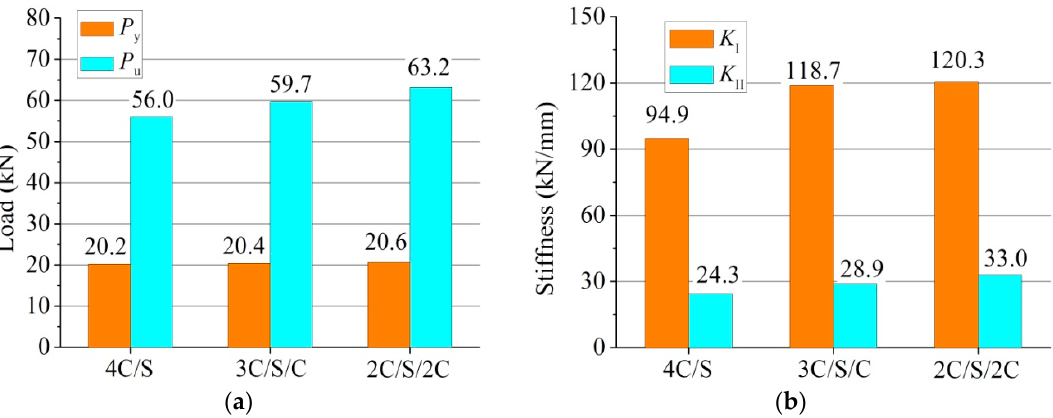
Figure 8. Effects of strengthening schemes: ( a ) yield and ultimate load of specimens; and ( b ) elastic and post-elastic stiffness of specimens.